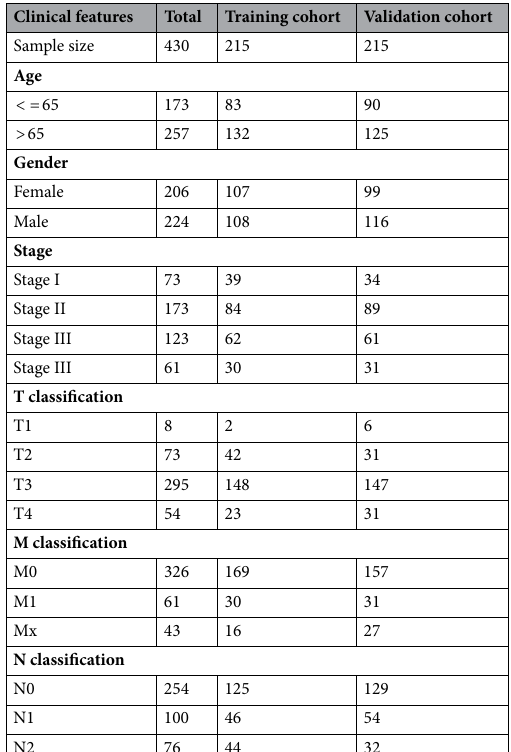
Table 2. The basic characteristics of the clinical variables in COAD